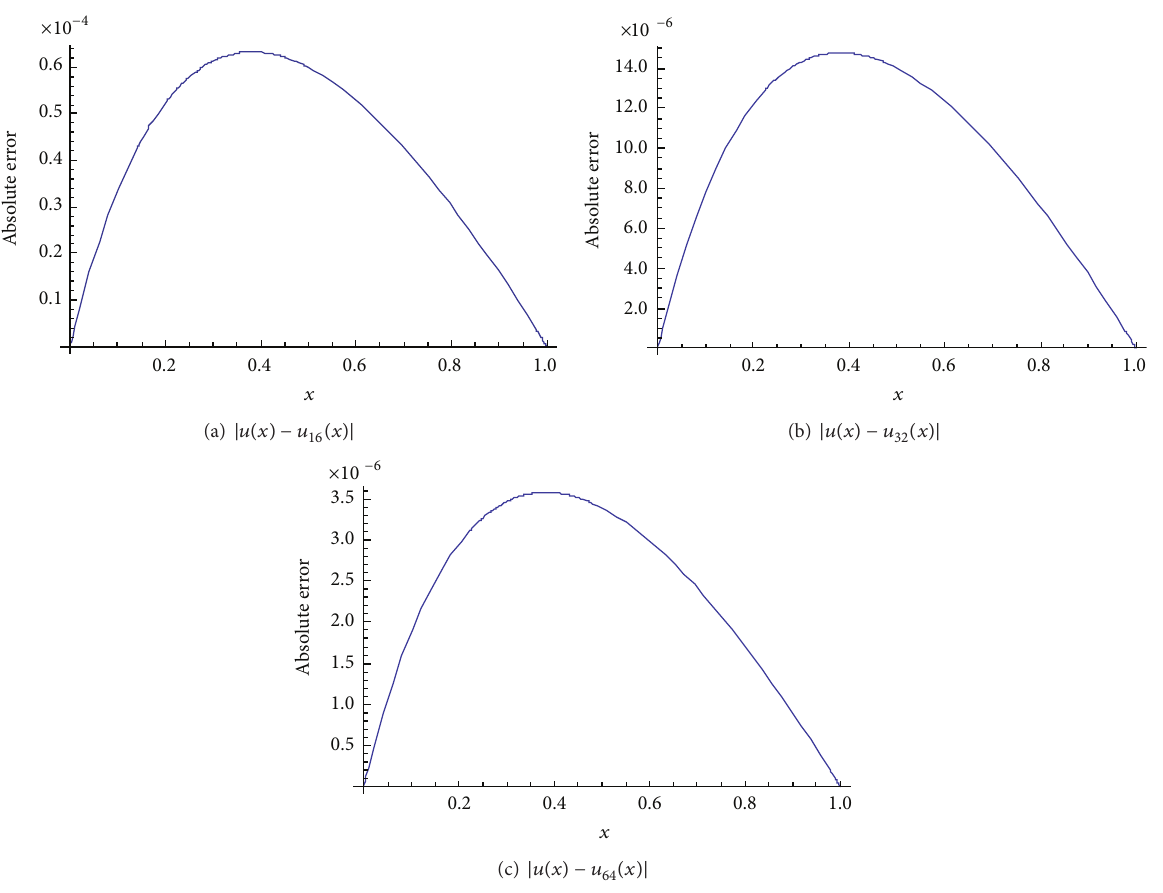
Figure 1: Figures of absolute errors |𝑢(𝑥) − 𝑢 16 (𝑥)| , |𝑢(𝑥) − 𝑢 32 (𝑥)| , |𝑢(𝑥) − 𝑢 64 (𝑥)| for Example 17.